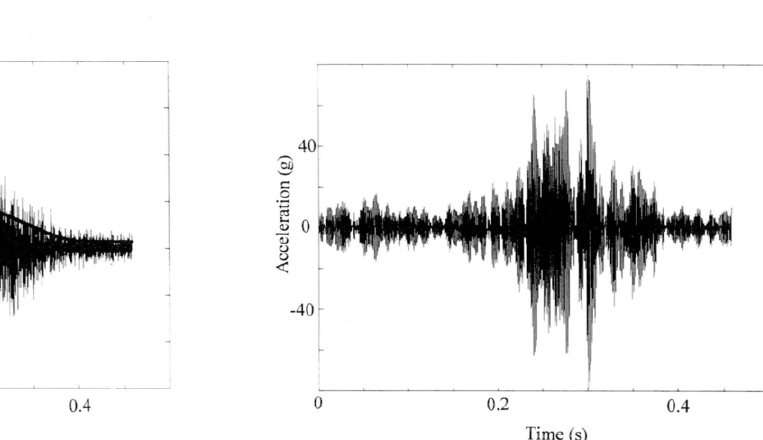
FIGURE 13 Realization of the simulation of the ad jacent missile firing response of Fig. 5.